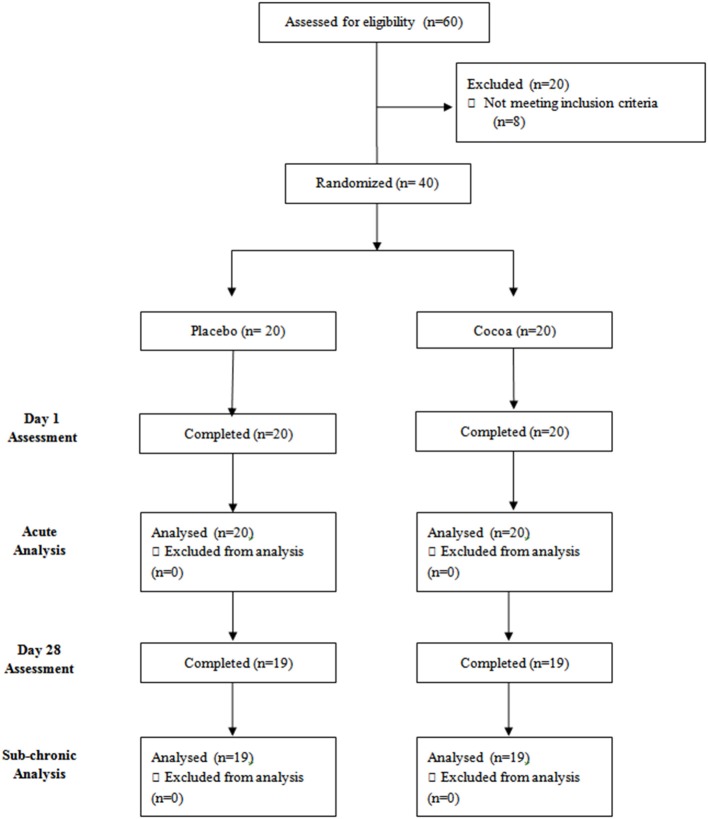
Study flow diagram.